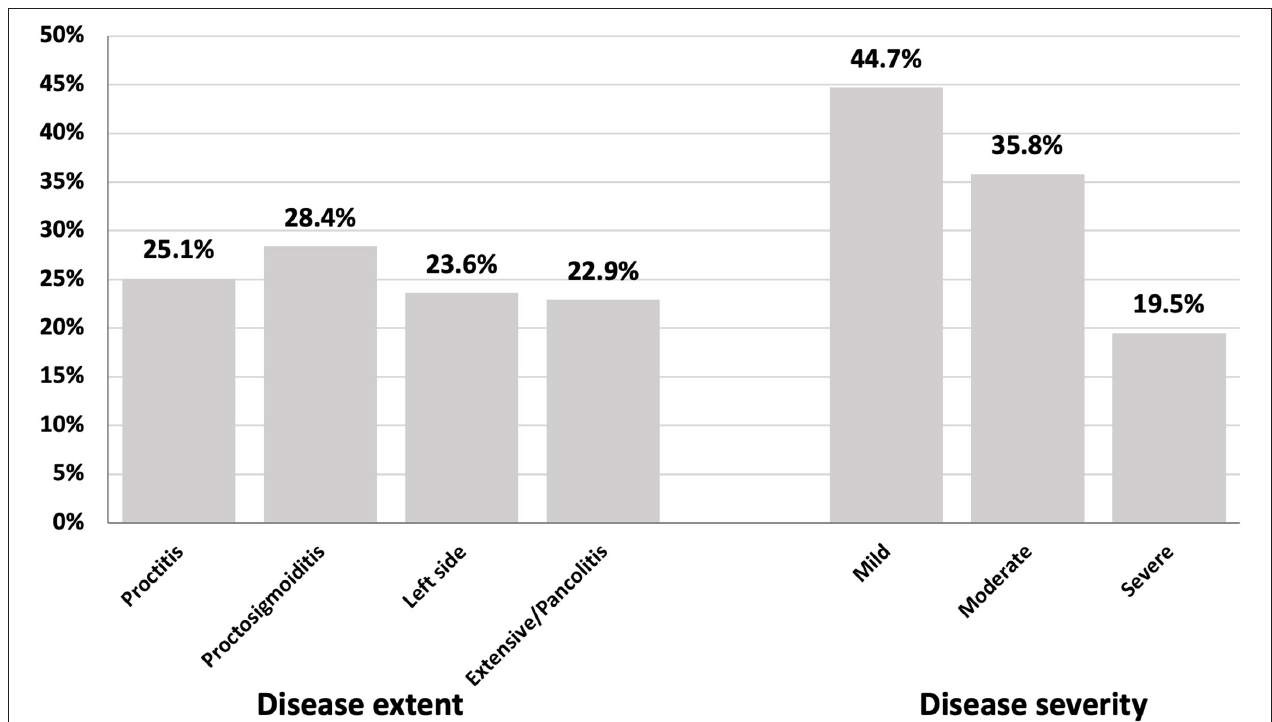
FIGURE 3 | Disease extent and severity by colonoscopy in patients with ulcerative colitis in Egypt (May 2018 to August 2021).